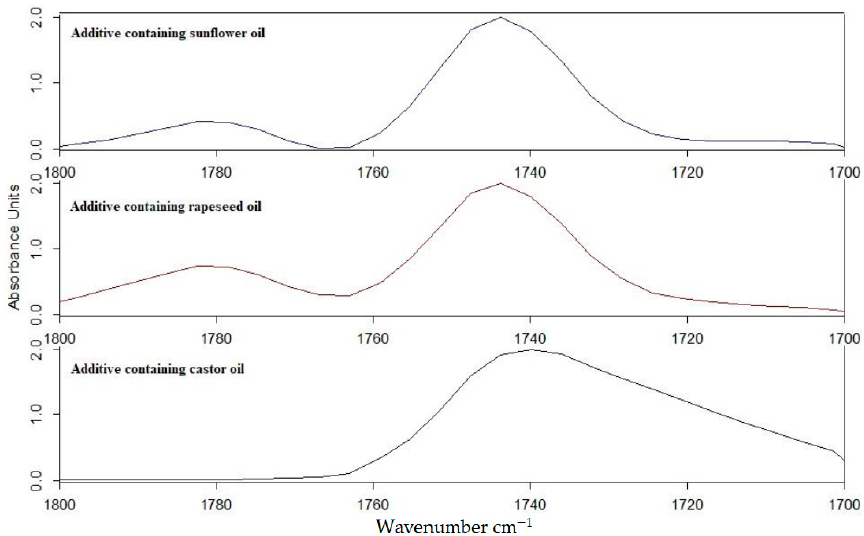
Figure 3. FT-IR spectra of vegetable oil-based additives in the wavenumber range 1800–1700 cm − 1 . In the wavenumber range of 3100–2800 cm − 1 , asymmetric and symmetric stretching vibrations of methyl and methylene groups are observed [15]. The difference between the synthesized additives is manifested in the wavenumber range of 1900–1600 cm − 1 . While in the wavenumber range of 1650–1630 cm − 1 and 1750–1730 cm − 1 , peaks (Figure 3) ap- peared for all three additives as well. In the range of 1790–1770 cm − 1 , peaks appeared only